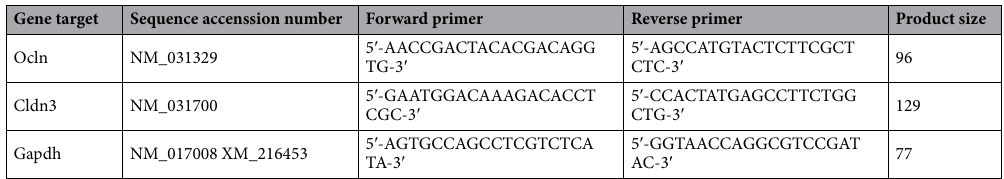
Table 3. Overview of primers. Targets include the genes for Occludin ( Ocln ), Claudin-3 ( Cldn3 ), and Glyceraldehyde 3-phosphate dehydrogenase (GAPDH, Gapdh